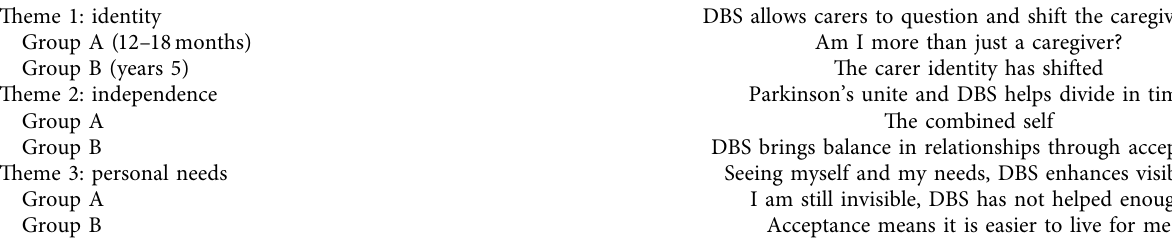
Table 3: Temes and subthemes by